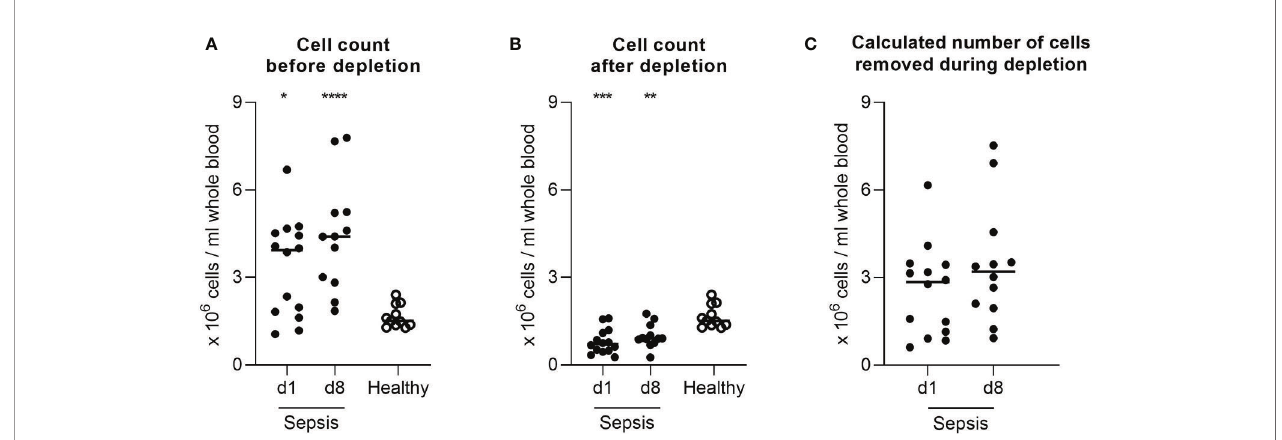
FIGURE 2 | Low-density granulocytic contamination is also re fl ected in the number of isolated cells. Cell yield per mL blood after in case of patients with sepsis (A) density gradient centrifugation and (B) additional depletion of CD15 + cells, in case of healthy volunteers ’ density gradient centrifugation. (C) Calculated total number of cells removed by the depletion process per mL blood in patients with sepsis. Each data point represents an individual patient (sepsis d1: n = 14; d8: n = 12/ healthy: n = 11). Horizontal lines mark the median. Group comparisons (sepsis vs . healthy) were performed using Mann-Whitney test (****P < 0.0001, ***P ≤ 0.001, **P ≤ 0.01, *P ≤ 0.05).